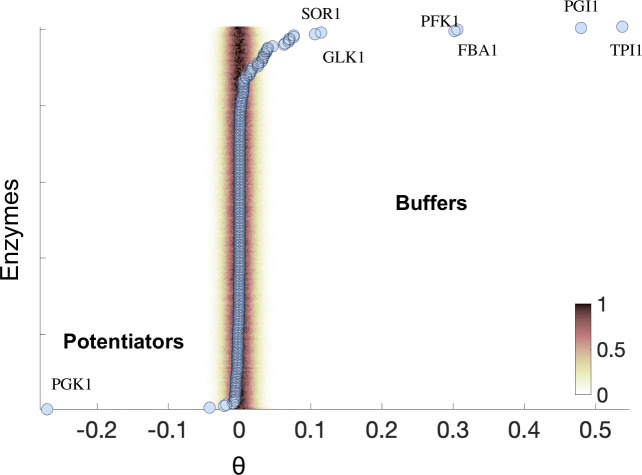
Buffers and Potentiators in yeast metabolism.For each enzyme, a θ score is computed, which is proportional to the difference in variability between the mutant and wild-type backgrounds. The shadow denotes the normalized null probability distribution of getting a particular score for each metabolic background. We added the names of the most significant modifiers (buffers with θ>0 and potentiators with θ<0).